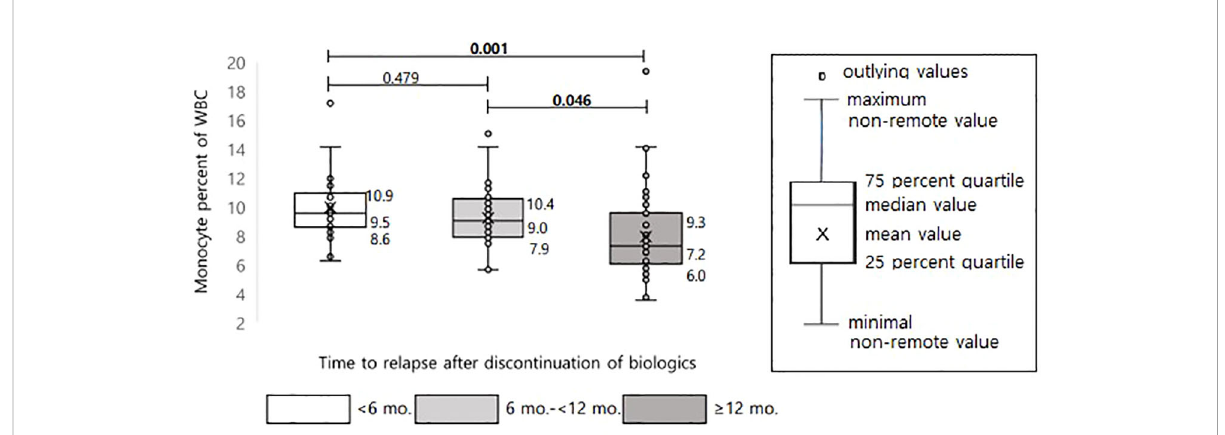
FIGURE 5 Differences in monocyte percentage of WBC according to time interval to relapse after discontinuation of biologics in pediatric patients with Crohn ’ s disease.